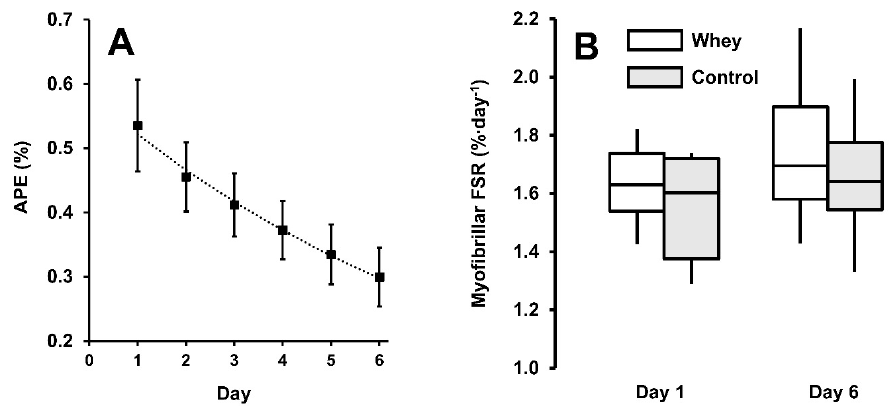
Figure 2. Body water deuterium enrichment (atom percent excess (APE) (%)) (A) , data are mean ± SD. Myofibrillar fractional synthetic rate (FSR) (B) , boxplot data are median (horizontal line), interquartile range (box), minimum and maximum (whiskers), there was no di ff erence between whey (white) and control (grey) groups ( p = 0.771).